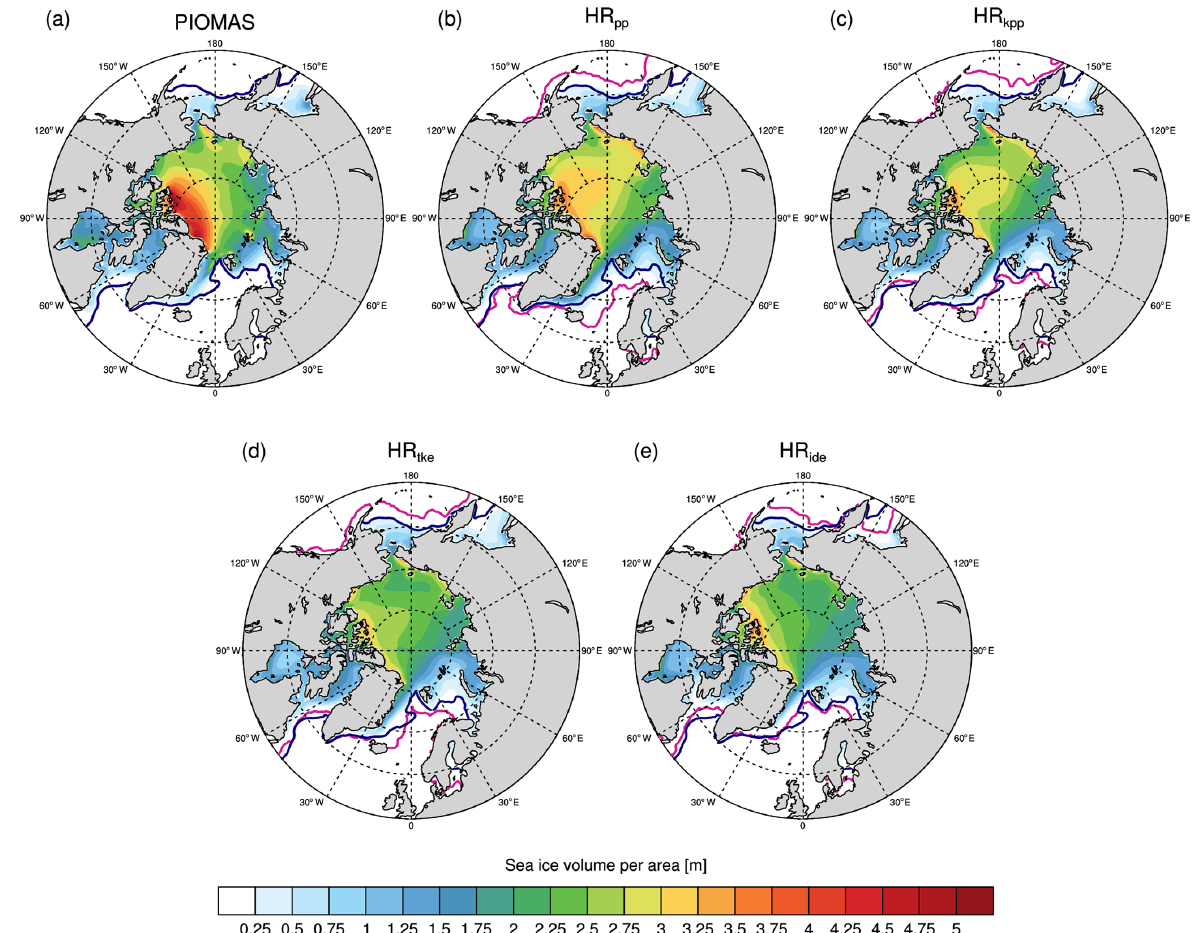
Figure 4. Time-averaged Arctic sea ice thickness in March for (a) PIOMAS reanalysis (March 1979–2005; Zhang and Rothrock, 2003; Schweiger et al., 2011), (b) HR pp , (c) HR kpp , (d) HR tke , and (e) HR ide . The 15% sea ice concentration of the EUMETSAT OSI SAF (averaged over March 1979–2005) is contoured in dark blue and those of the simulations in